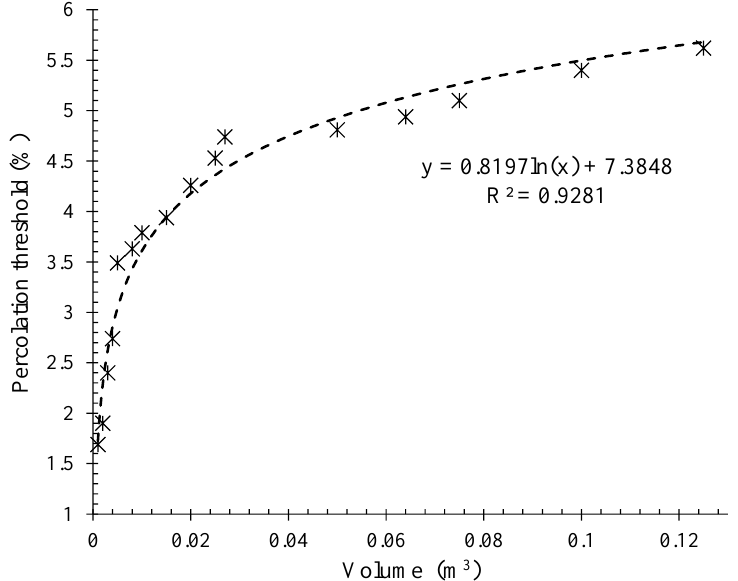
Figure 13. Relation between electrical percolation threshold and matrix volume for CNT/GNP reinforced specimens with different volumes.